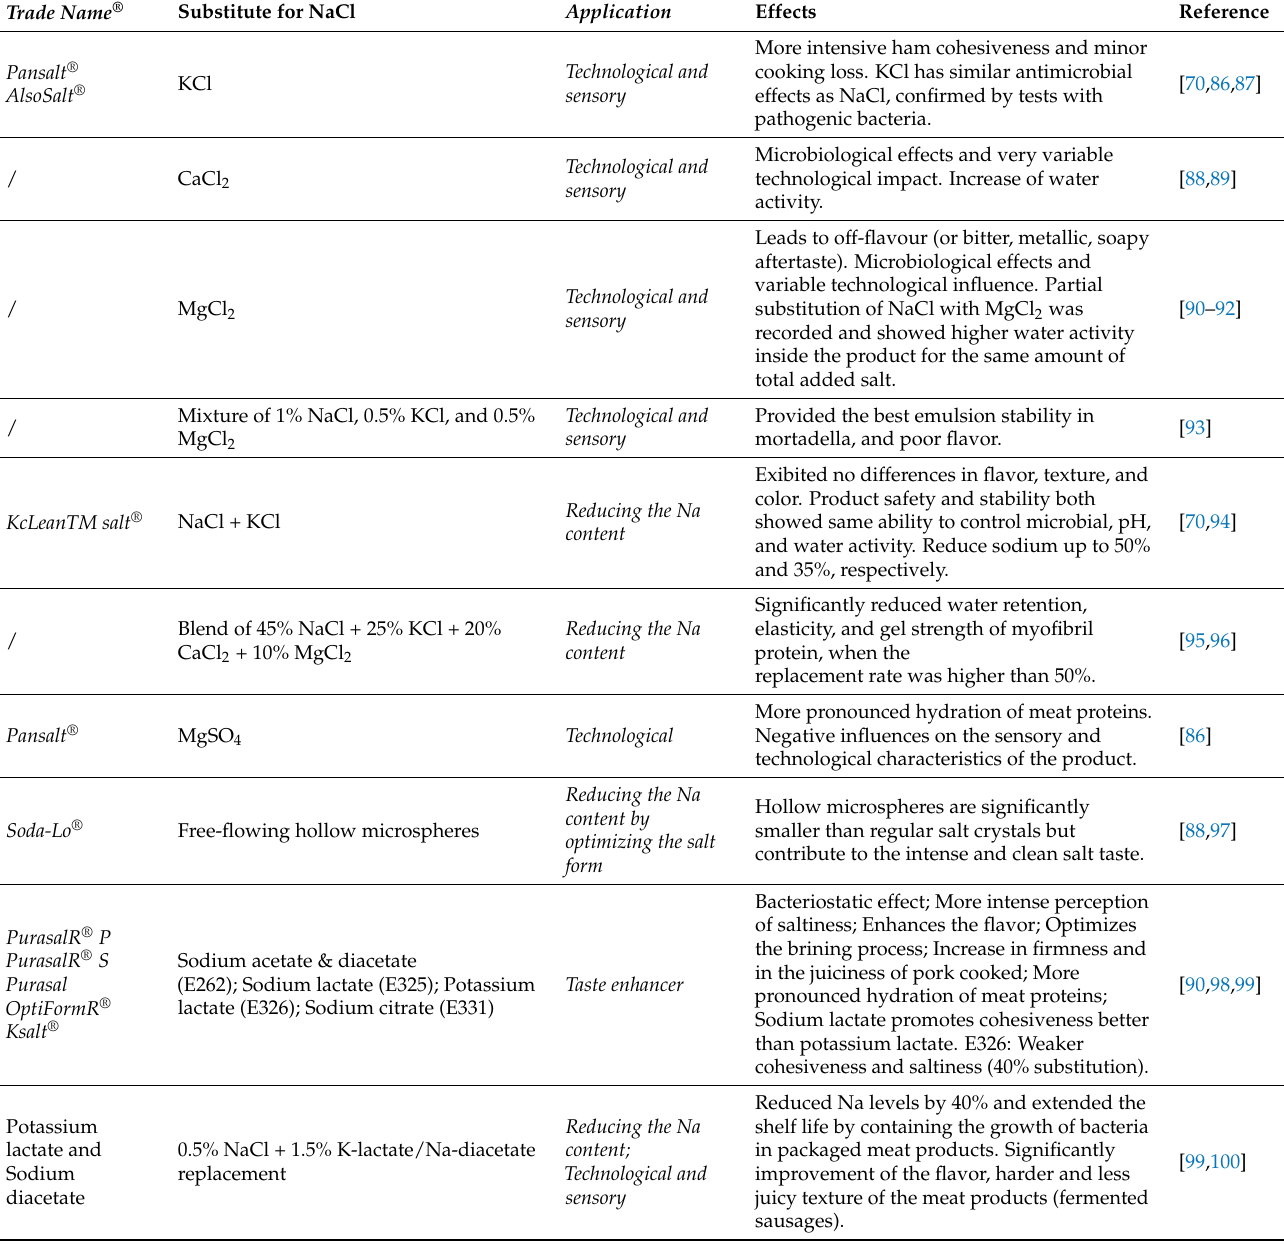
Table 1. Various types of replacers for NaCl in meat products—application and